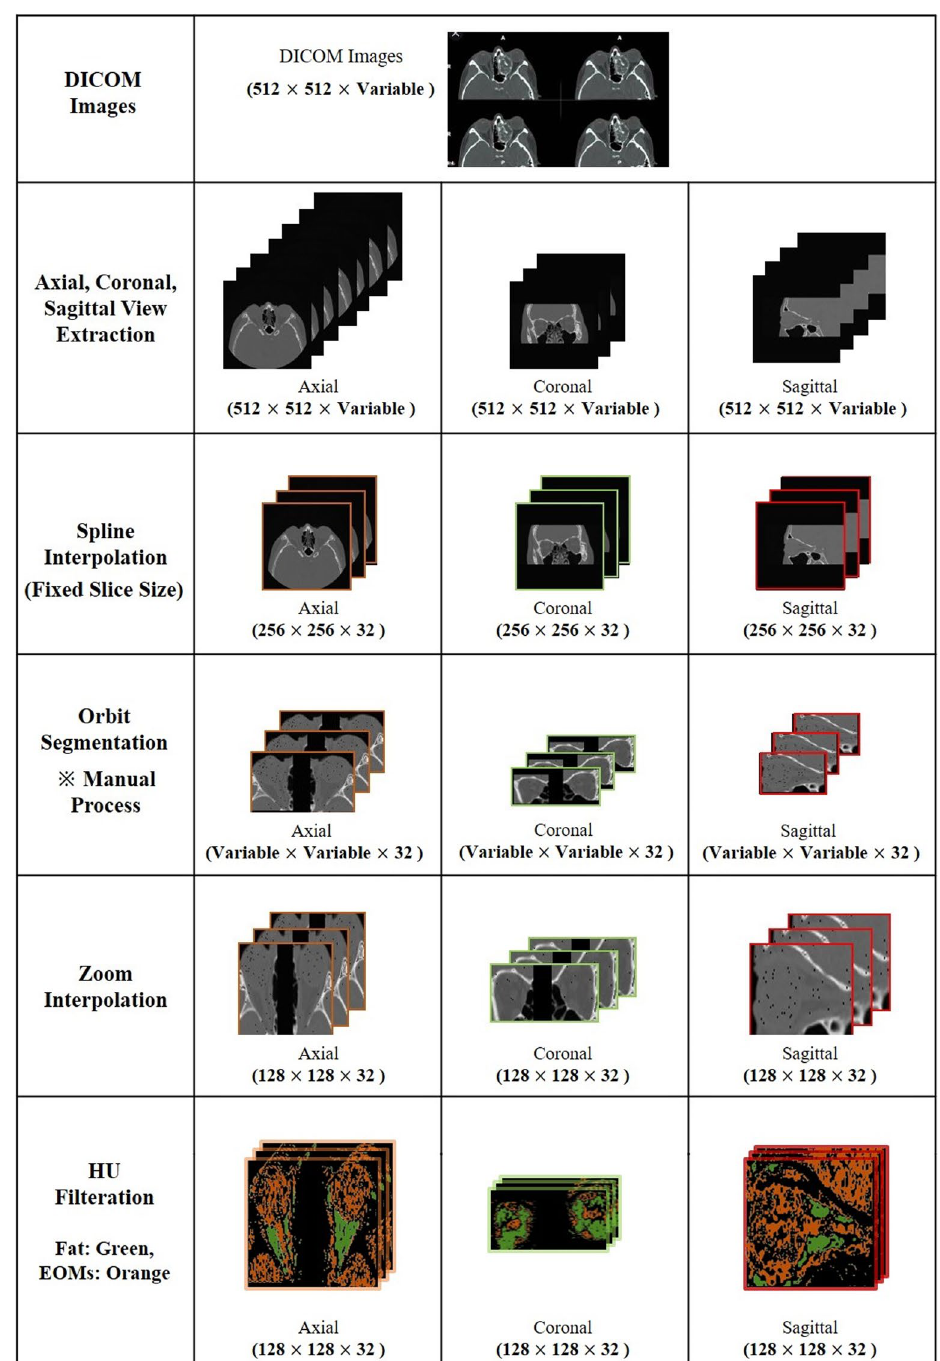
Figure 3. Data preparation process. The soft tissue thresholds were set at −100 to + 40 attenuation values in Hounsfield units (HU) to remove unnecessary pixels. Manual cropping was performed, and the extracted region of interests (ROI) were unified in size by